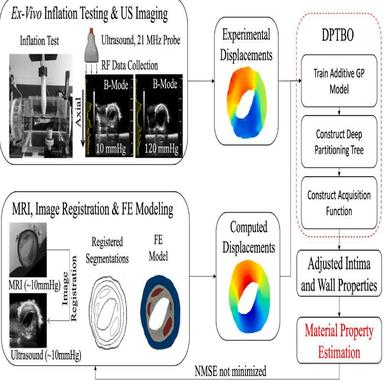
iFEM pipeline comprising of three main parts, namely the ex-vivo inflation testing combined with ultrasound imaging, MRI geometry based FE modeling and the DPTBO.